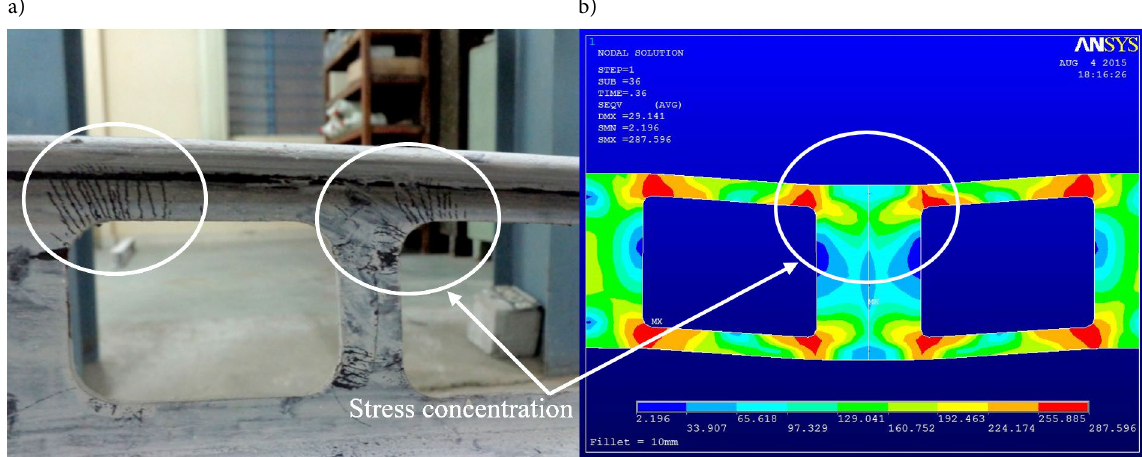
Fig. 8. Stress concentrations around the corners region of openings (Vierendeel mechanism): a – experimental; b –